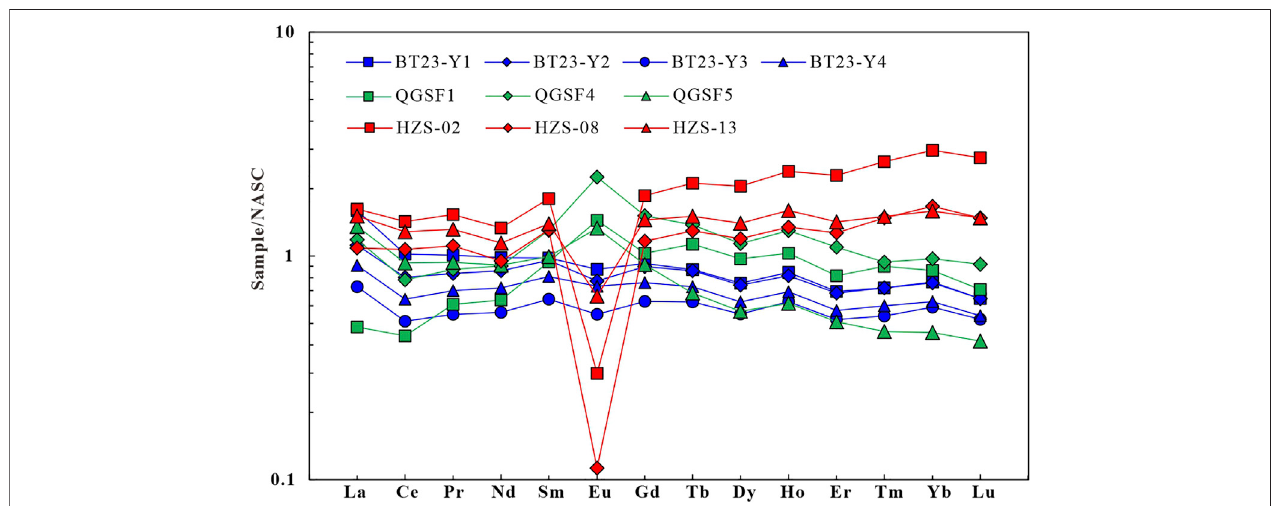
FIGURE 10 | Standardized allotment map of North American shales in the study area rocks (Qugasi Formation data (QGSF1, 4, 5) according to Wang H Y, 2017; HZS data according to Zhang F. Y. et al, 2018).